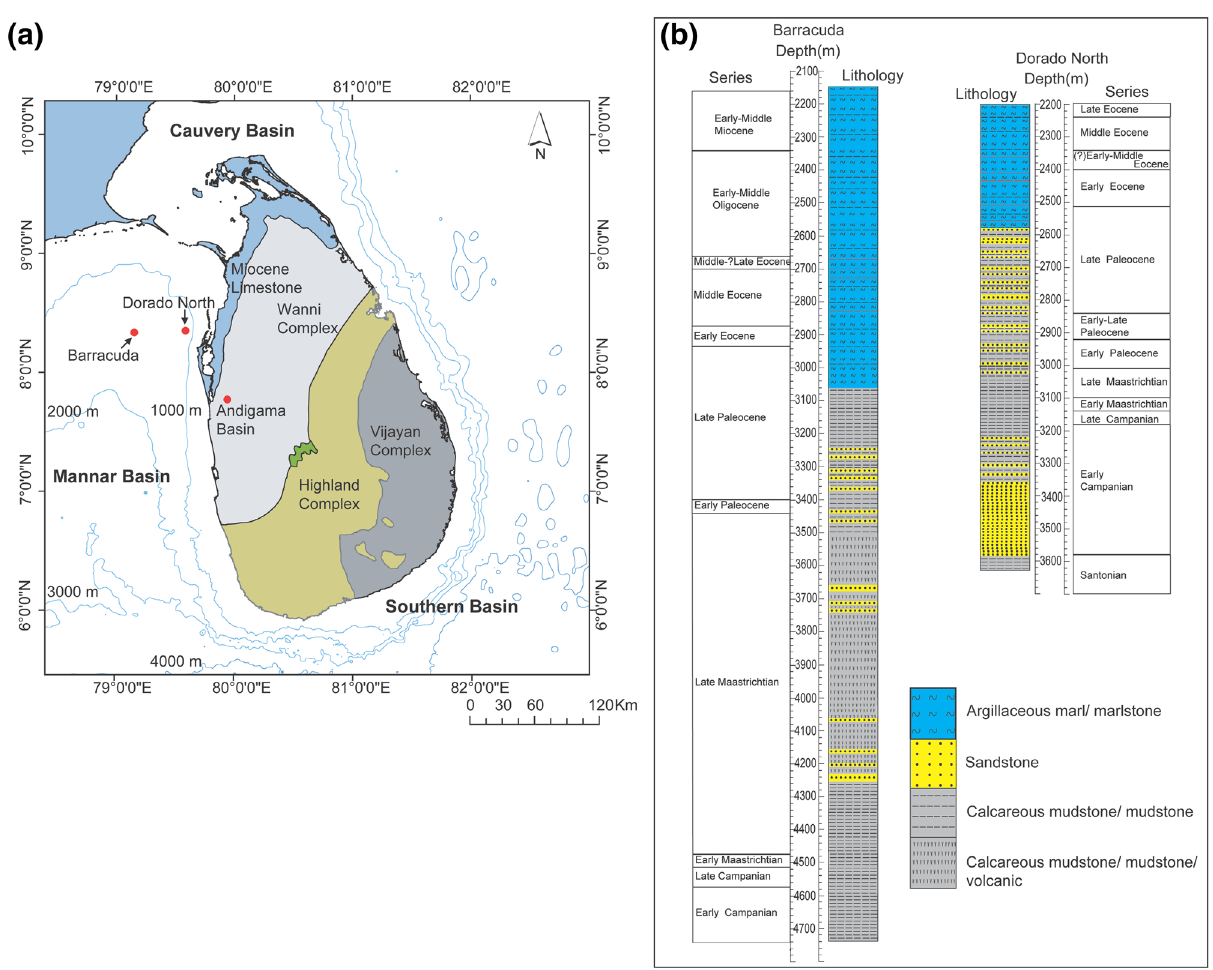
Fig. 1 a Simplified geological map of Sri Lanka showing the loca- tions of hydrocarbon exploration wells in the offshore Mannar Basin and location of the adjacent onshore Andigama Basin, b simplified